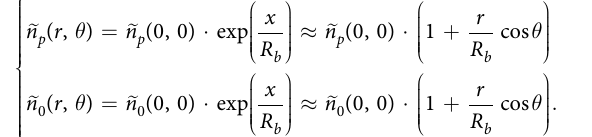
Figure 11. The bent fiber model. A local polar coordinate system (  r The center of the bent fiber with a bending radius R b is set as the coordinate origin  O along the direction of bending. The fiber core center is located at the point ( D , θ  another local polar coordinate system ( r , θ ) for fiber